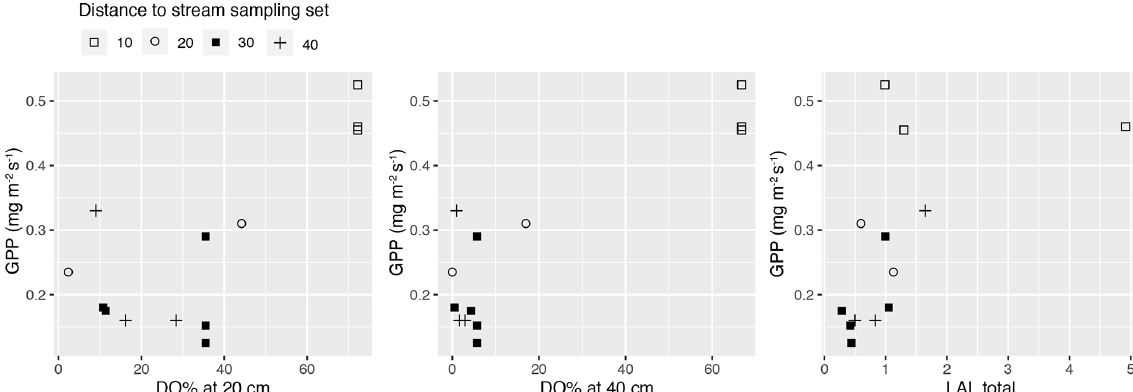
Figure A6. Gross primary production (GPP) at a photosynthetic photon flux density level of 800µmolm − 2 s − 1 in the methane (CH 4 ) flux sample plots in sets 10–40 plotted against peak season (early summer) dissolved oxygen concentration (DO%) at 20 and 40cm below the surface, and the peak season (late July) total vascular leaf area index (LAI_total). Plots in the same set are labelled using the same symbol.